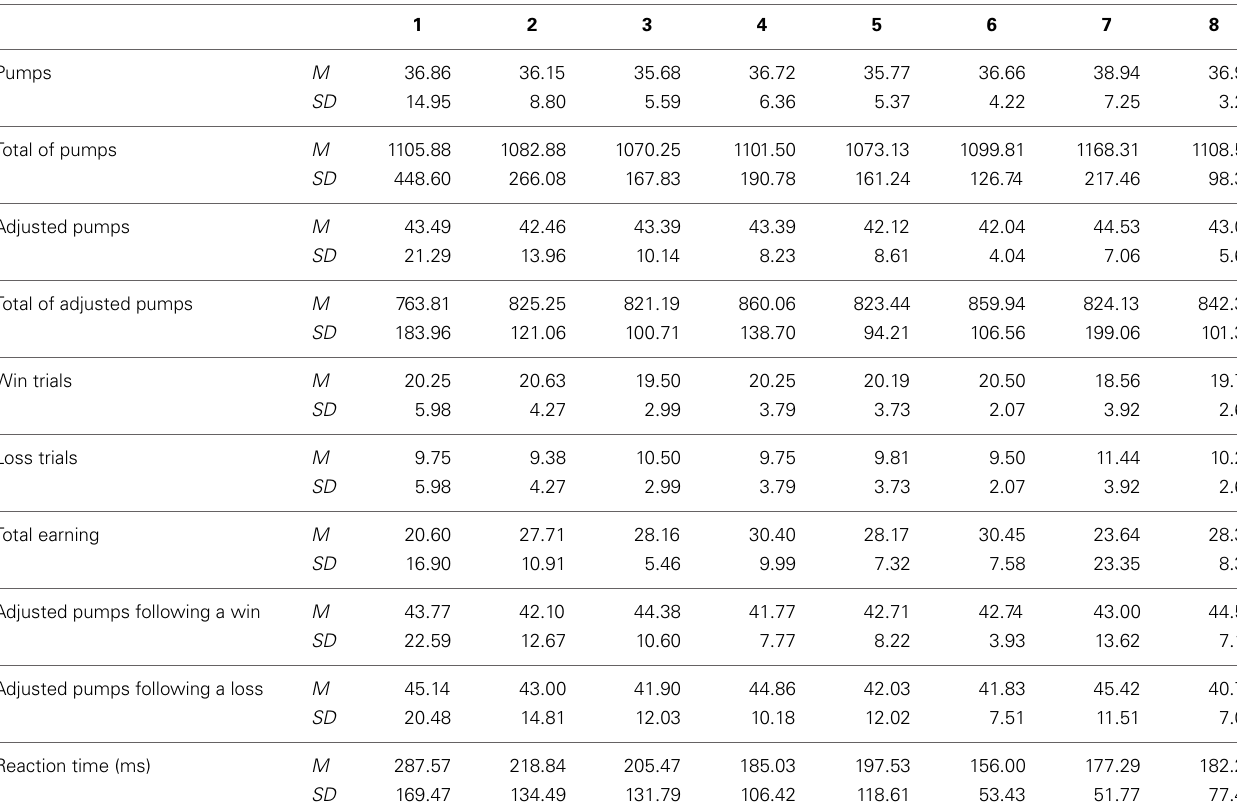
Table 1 | The results of the behavioral